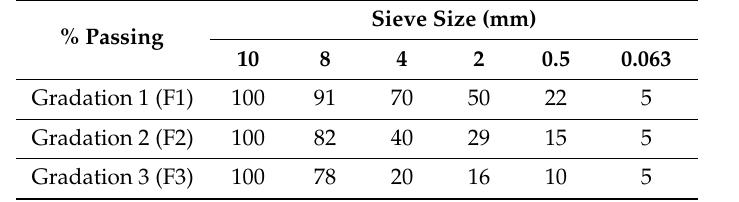
Table 1. Passing percentage for the designed aggregate gradations for stage 1.